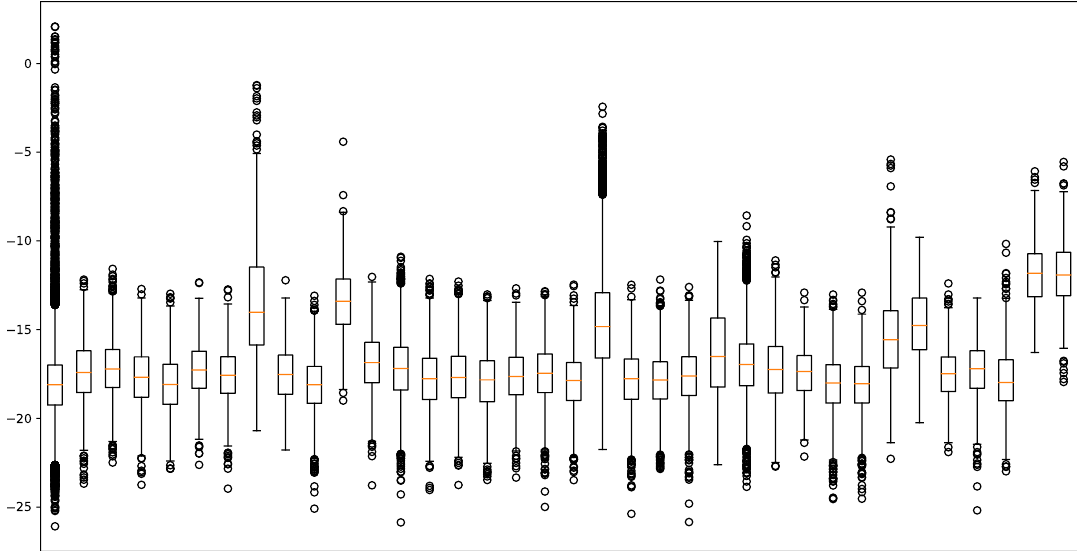
Figure 4. Boxplot of blackscatteringsigma naught of the flooded (FLD) and non-flooded paddy field (F01–F35)